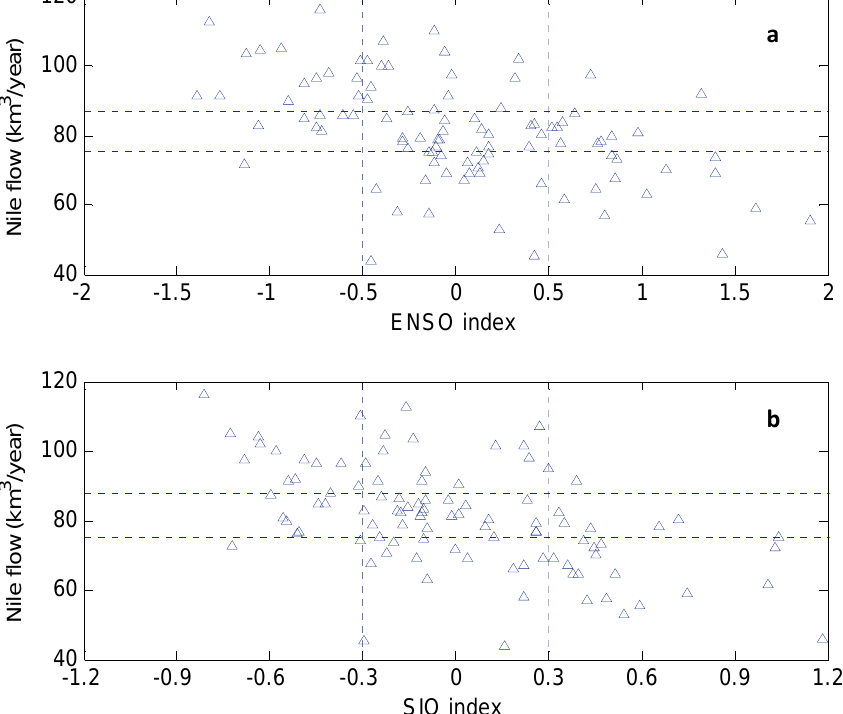
Figure 7. Relations between the annual Nile flow and different indices for the period (1900–2000): (a) ENSO and (b) SIO. The horizontal lines represent the boundaries for the “high”, “normal” and “low” categories of the annual flow. The vertical lines represent the boundaries for the “warm”, “normal”, and “cold” conditions for the ENSO and SIO indices.